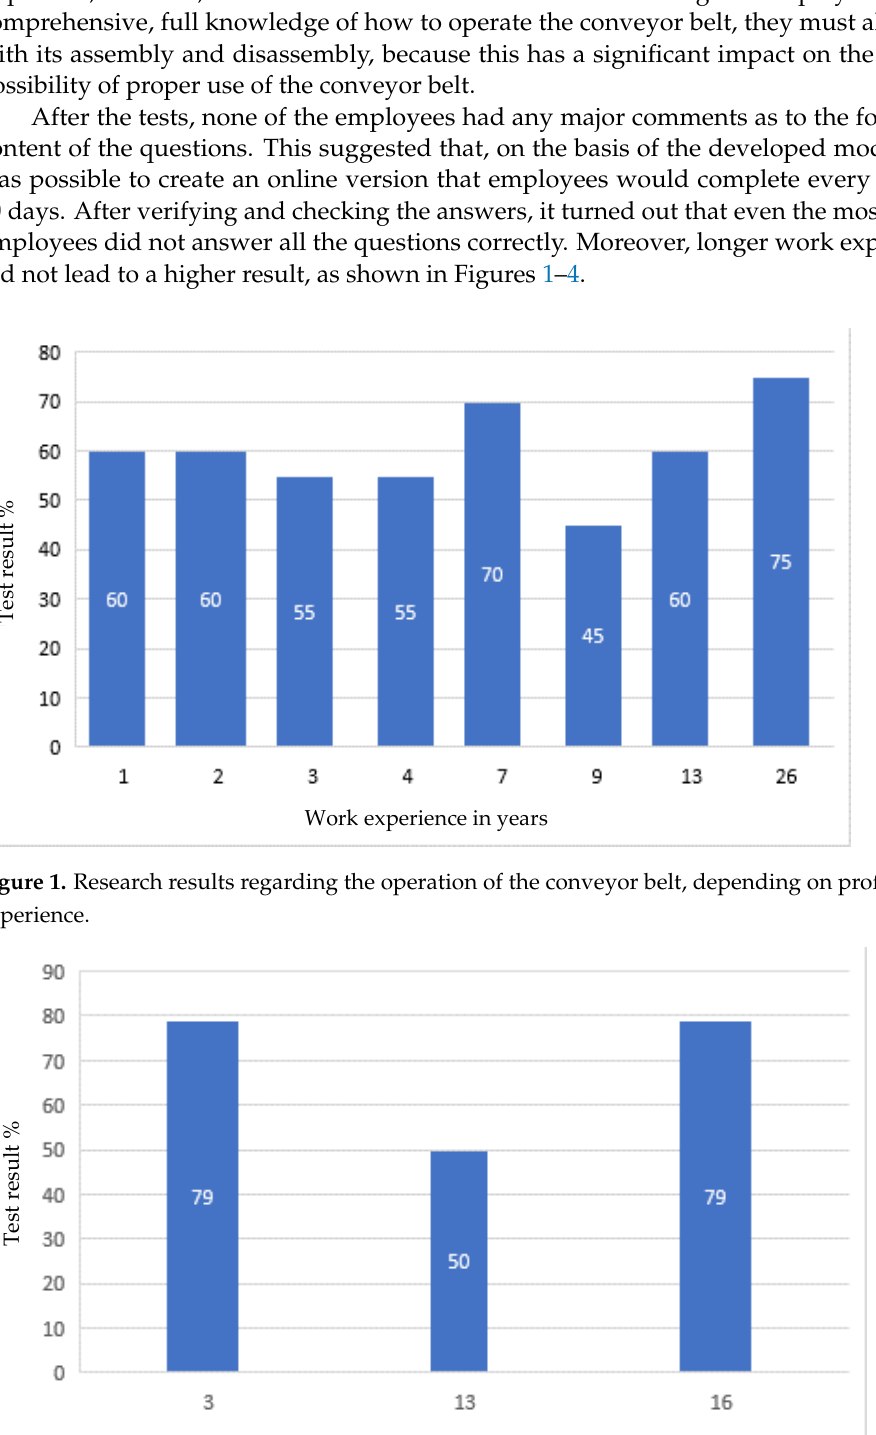
Figure 3. Research results regarding repair and maintenance of the conveyor belt, depending on professional experience.